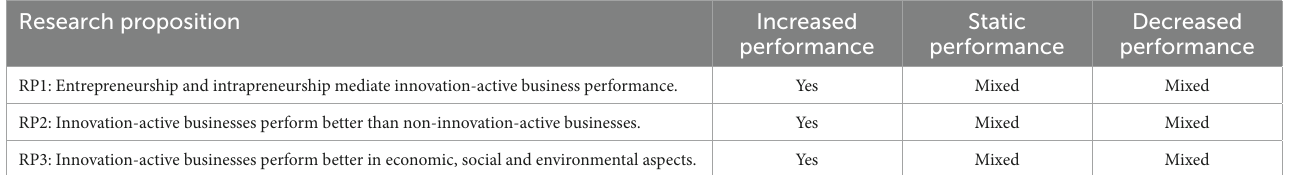
TABLE 4 Summary of